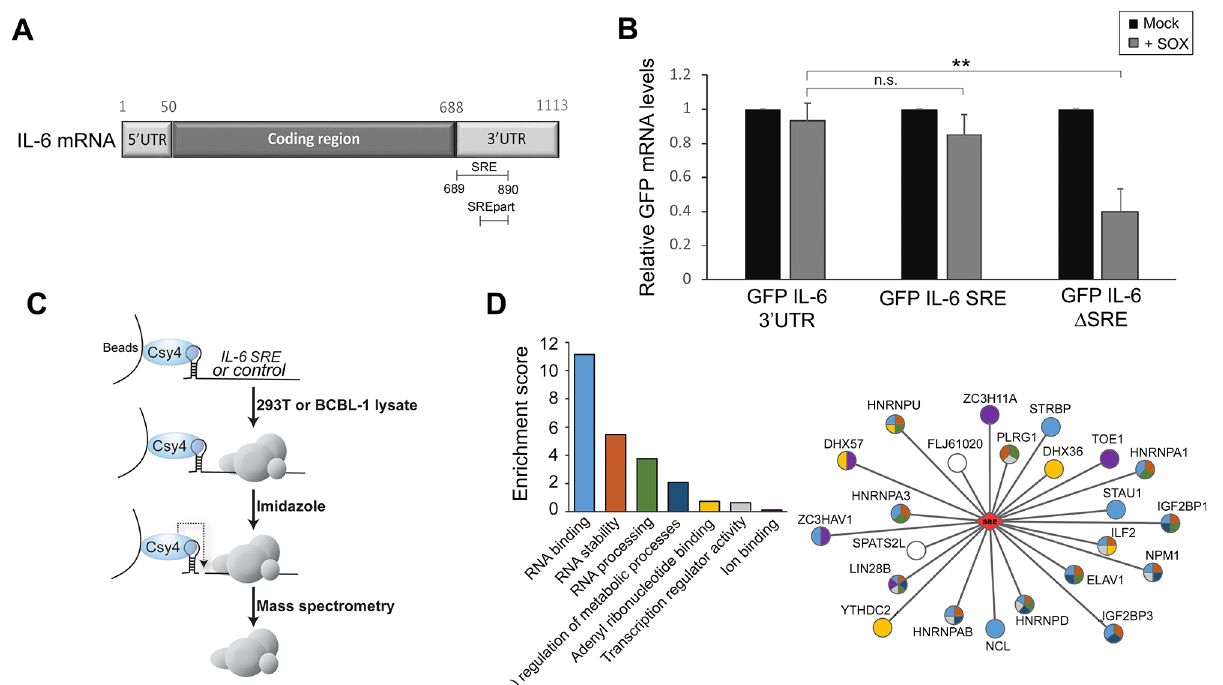
Fig 1. Identification of the RNP complex associated with the IL-6 SRE. (A) Schematic representation of the IL-6 mRNA. SRE refers to the complete protective sequence, whereas SRE part refers to the portion of the SRE characterized previously [18]. (B) 293T cells were transfected with the indicated GFP-IL-6 fusion constructs in the presence or absence of a plasmid expressing SOX. After 24 h, total RNA was harvested and subjected RT-qPCR to measure GFP levels. Statistical significances here and for the following figures were determined by Student t test ( * p < 0.1; ** p < 0.05; *** p < 0.01) (C) Schematic representation of the Csy4-based RNP purification strategy. (D) A GO term analysis was performed using DAVID bioinformatics database on the high confidence proteins identified by Mass Spectrometry. The histogram on the left shows enrichment scores for the 7 clusters found in the GO term analysis. The network representation on the right shows the 23 proteins identified by MS as SRE binding proteins with the colors in the nodes showing their GO term association based on DAVID